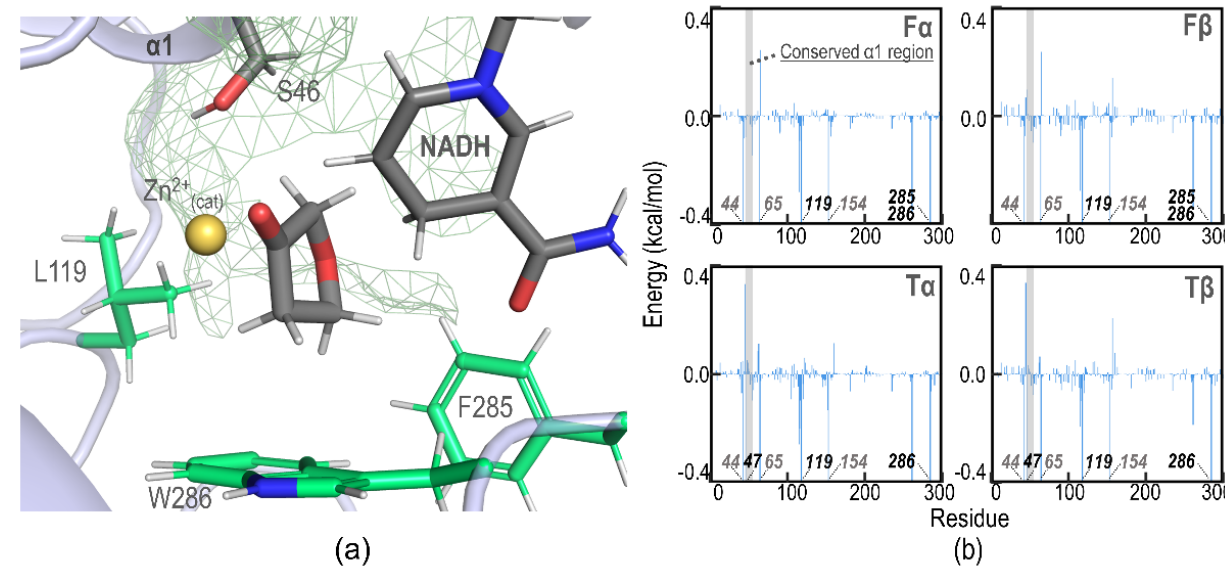
Figure 4. Induced fit of substrate into the L119 − F285 − W286 small cavity. ( a ) While the substrate ( F α in this figure) is bound to the small cavity, the remaining surface area is exposed (green mesh). L119 borders between the large and the small cavity. ( b ) MMPB-SA binding affinity analysis of residue wide decomposition. The residues with binding energy stronger than 0.4 kcal/mol were marked. The grey zone denotes the conserved α 1 region constructing the large cavity. The grey numbers are the zinc coordinating